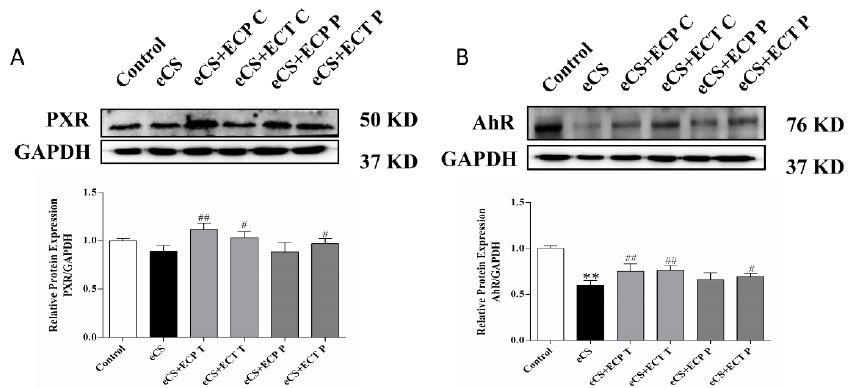
Figure 8. The effects of ECP and ECT on the expression of the PXR and AhR protein in the liver of mice exposed to eCS. Western blot analysis for the expression of ( A ) PXR and ( B ) AhR in liver tissues of mice induced by eCS. The measures represent mean ± SD. **: compared with the blank control group, p < 0.01; #: compared with the eCS model group, p < 0.05; ##: compared with the eCS model group, p <